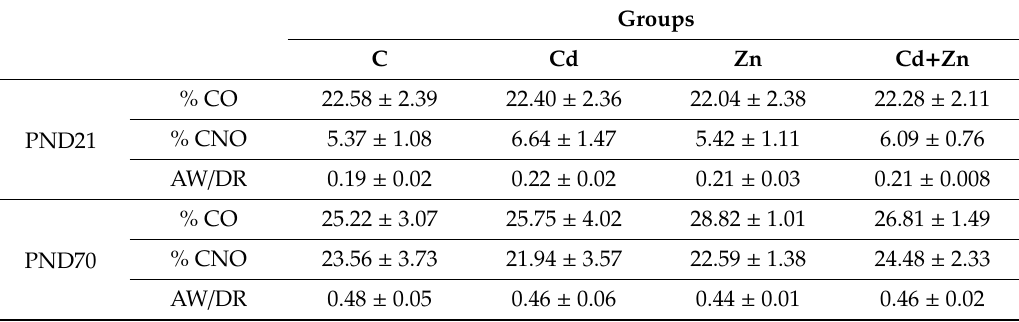
Means ± SEM from six samples in each groups. No significant differences have been observed between the four groups at PND 21 and PND70.